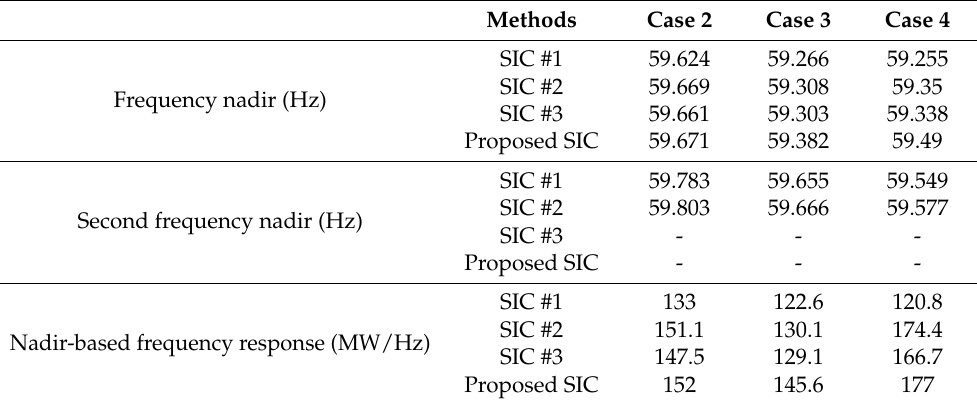
Table 1. Summary of Case 2, Case 3, and Case